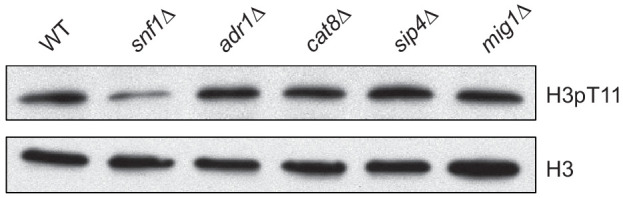
H3pT11 depends on Snf1, but not on Snf1 target transcription factors.Global H3pT11 levels in WT (BY4741), snf1Δ, and the deletion mutants of Snf1 target transcription factors (adr1Δ, cat8Δ, sip4Δ, and mig1Δ) analyzed by western blots. The cells were taken from overnight saturated cultures in YPD media.